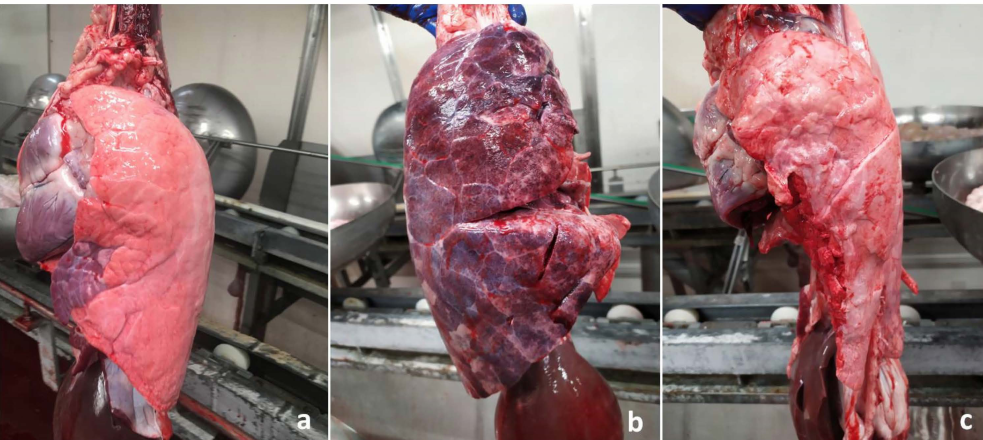
Figure 1. Slaughtered pigs. Lungs. ( a ) The image clearly shows the external surface of the left lung, an EP-like lesion affecting the middle lobe; this kind of picture was considered suitable for the present investigation. ( b ) The right lung has a diffuse reddish appearance, because of the inspiration of blood after exsanguination. ( c ) A large portion of the left lung is missing, as it remained attached to the chest wall because of chronic pleurisy. Both ( b , c ) pictures were considered unsuitable and were not included in this